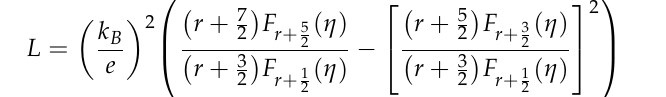
Figure 5. ( a ) Temperature-dependent total thermal conductivity κ total (T); ( b ) Lorenz number L(T) ; ( c ) lattice and bipolar thermal conductivity κ lattice + bipolar (T) ; ( d ) total thermal conductivity (black square) and lattice and bipolar thermal conduc- tivity (red circle) as a function of the Cl-doping concentration of the Pb 0.79 Sn 0.25 Se 1 − x Cl x (x = 0.0, 0.2, 0.3, 0.5, 1.0, 2.0 mol.%) and Pb 0.75 Sn 0.25 Se compounds.